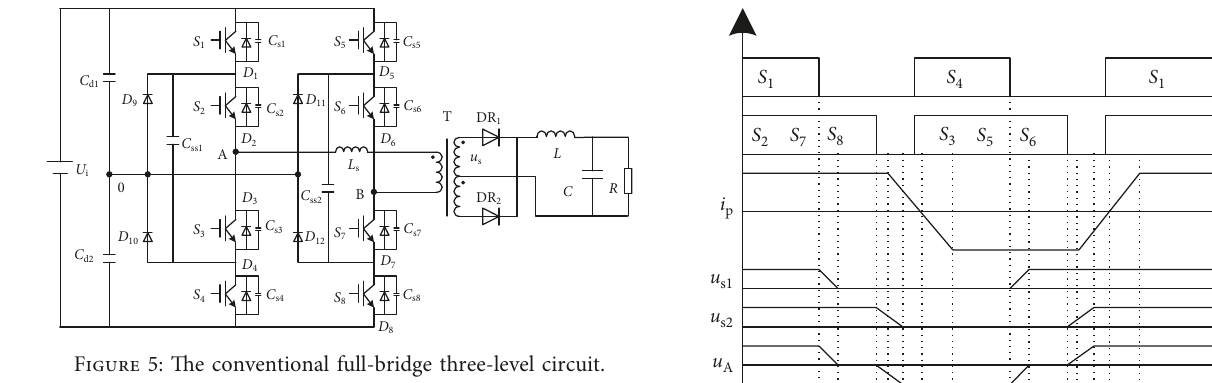
Figure 5: The conventional full-bridge three-level circuit.